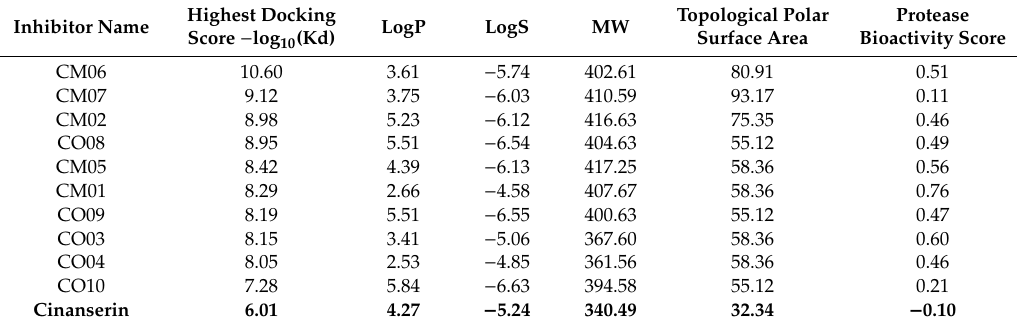
Table 9. Docking scores, predicted LogP, predicted LogS, topological polar surface area (TPSA), and protease bioactivity values of successfully docked cinanserin and optimized cinanserin compounds.